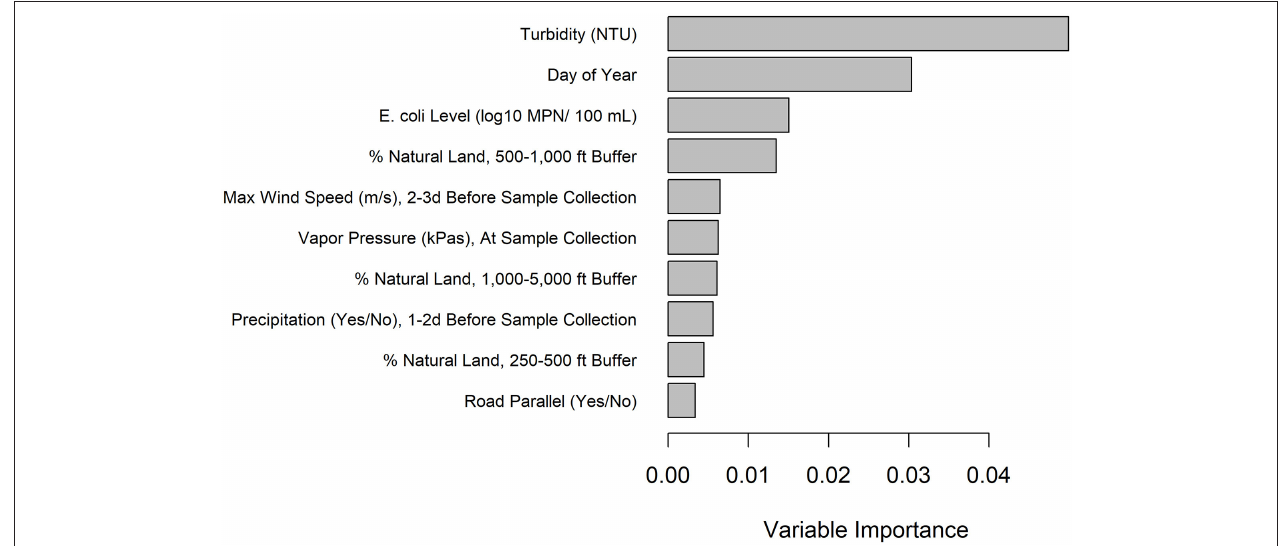
FIGURE 1 | Variable importance values for the Salmonella conditional forest model with generic E. coli included as a predictor. Only the top 10 predictors are included and are listed from most to least